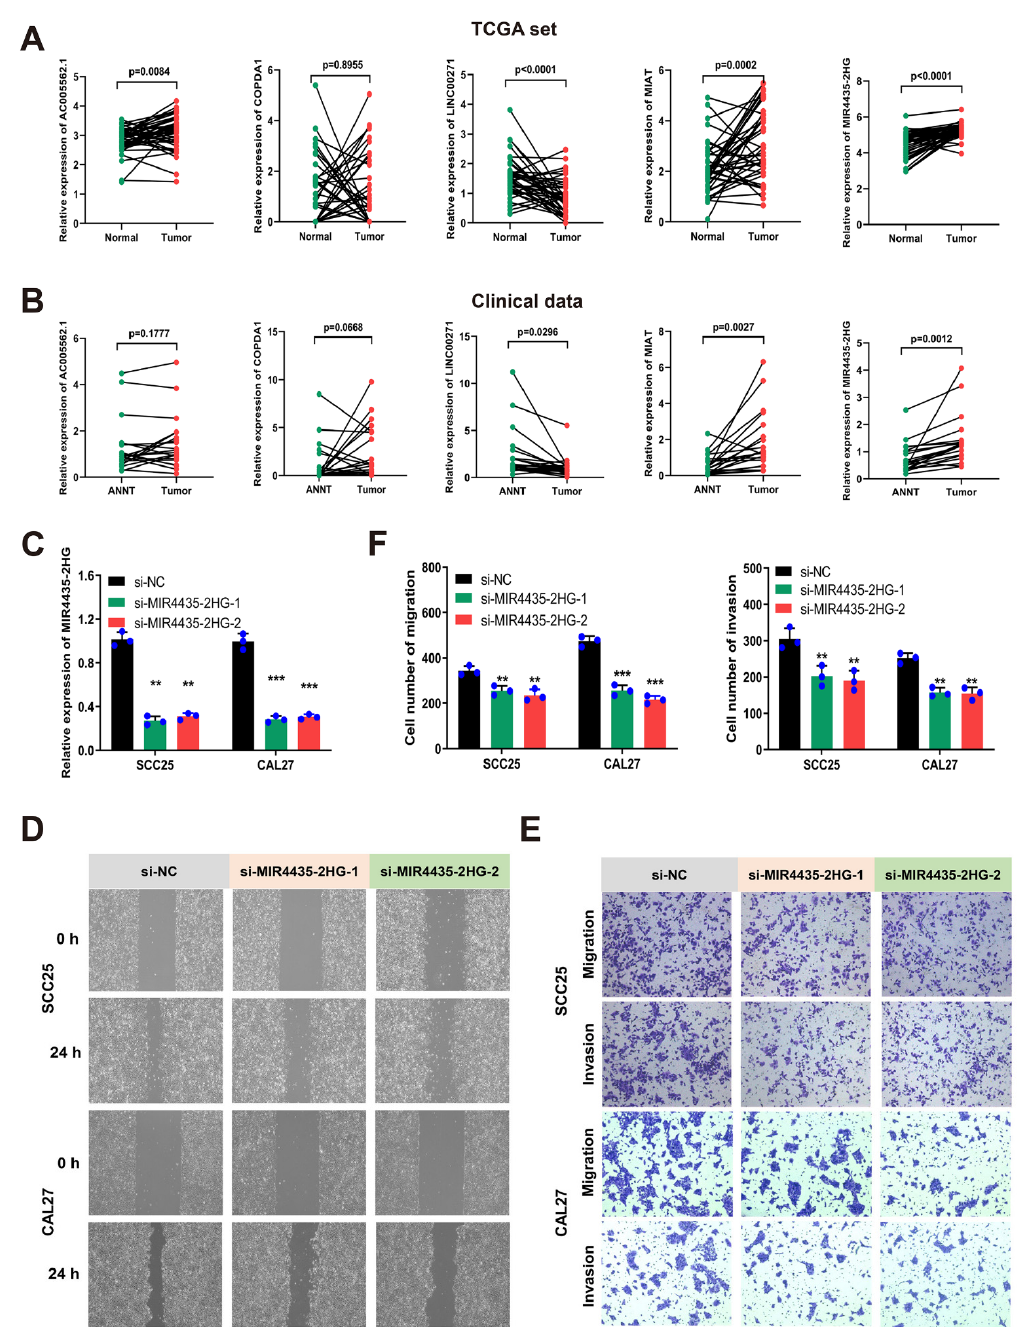
Figure 7. MIR4435-2HG was highly expressed in HNSCC tissues and promoted cell migration and invasion. ( A ) The expression of 5 m 6 A-related eRNAs between 43 tumor tissues and paired normal tissues in the TCGA-HNSCC cohort; ( B ) the expression of 5 m 6 A-related eRNAs between 20 HNSCC tissues and paired ANNT; ( C ) RT-qPCR analysis of SCC25 and CAL27 cells after transfection with si-MIR4435-2HG; ( D ) wound-healing assay images of SCC25 and CAL27 cells after transfection with si-MIR4435-2HG; Magnification at 40 × ; ( E , F ) representative photographs ( E ) and plots of statistical analysis ( F ) of migration and invasion assays of SCC25 and CAL27 cells after transfection with si- MIR4435-2HG; Magnification at 100 × . The experiment was repeated three times; error bars indicate SD. (** p < 0.01, *** p <